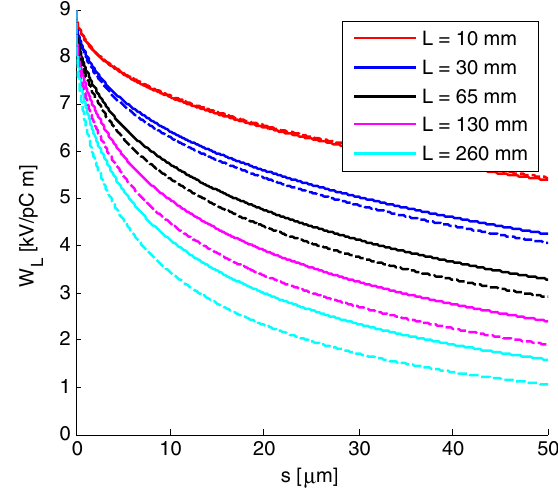
FIG. 5. Short-range longitudinal wake functions were calcu- lated using KB (solid lines) and KB* (dashed lines) models in the periodic structure of radius a ¼ 2 mm for different values of L (see color code in the legend).